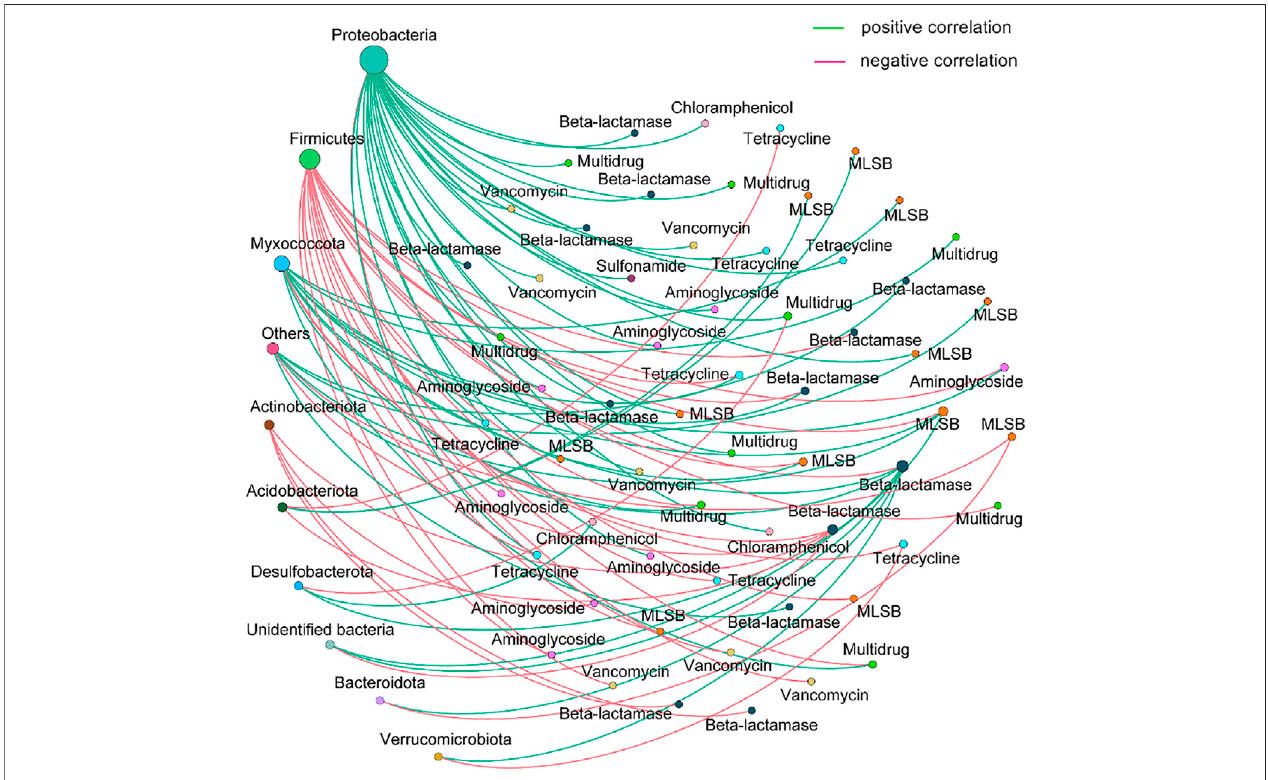
FIGURE 5 | Network co-occurrence analysis between the microbiome and antibiotic resistome. The size of each node is proportional to the number of connections.